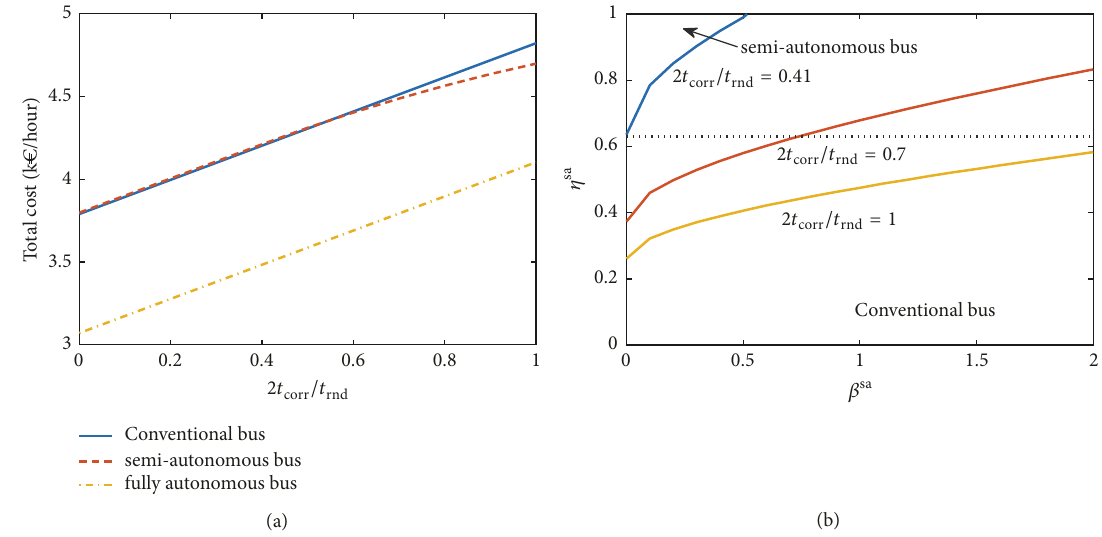
Figure 7: (a) Total cost and (b) applicability of semi-autonomous bus with respect to different ratios 𝜆 between corridor and total travel time. Note that the top-left side of each curve in (b) indicates the preferable region of semi-autonomous buses, whereas the other side is for conventional buses. The dotted line gives the upper bound of 𝜂 sa , which is 0.63. Other parameters according to Table